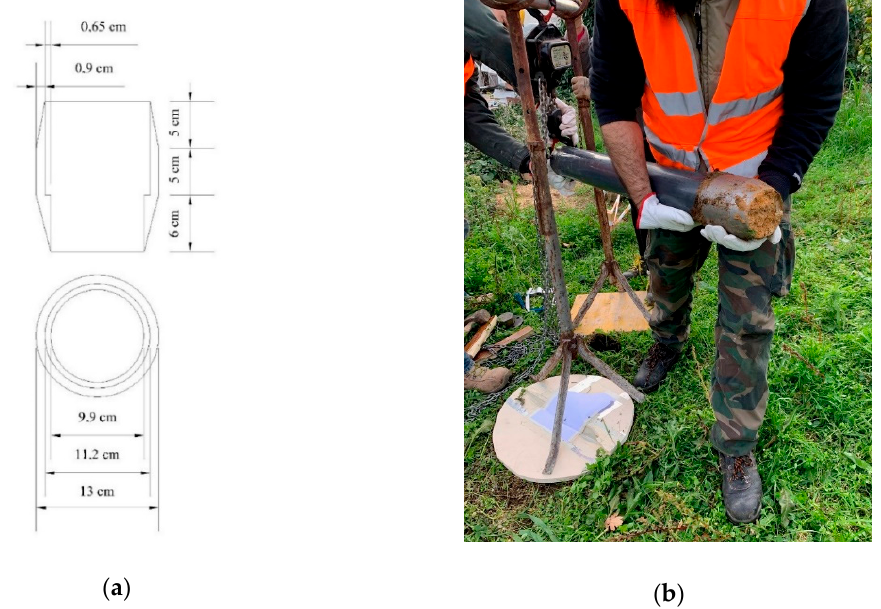
Figure 6. ( a ) Details of the specifically developed lower ring with a cutting edge; ( b ) The components as mounted on the sampler during on-site collection.